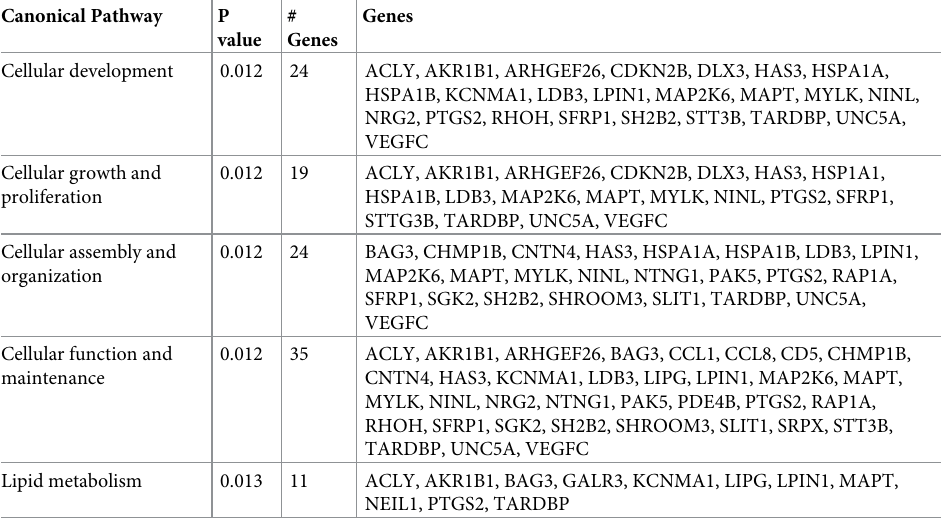
Table 4. Significant molecular and cellular functions for DEGs associated with the gain main effect identified using